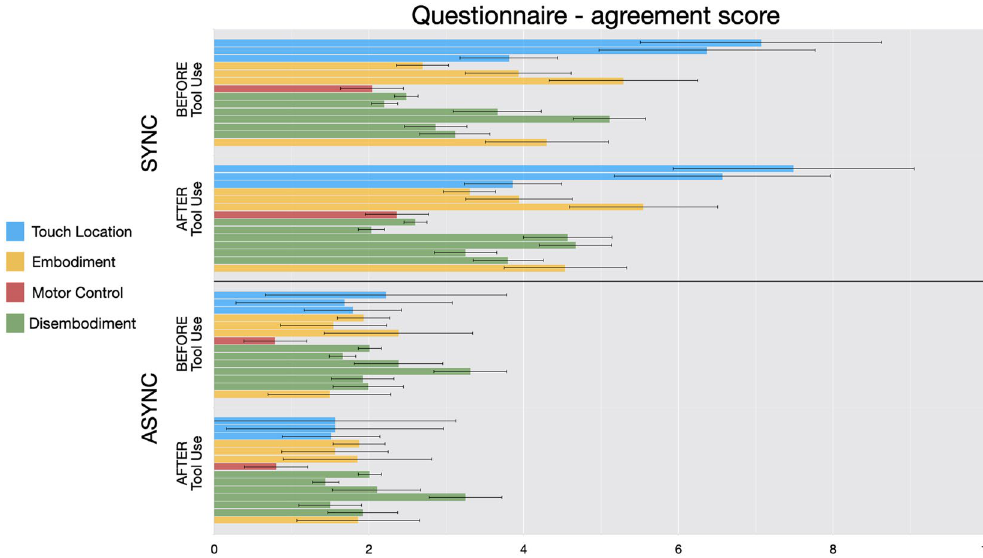
Figure 4. In Experiment 2, participants (N = 40) showed higher agreement for statement regarding changes in perceived touch location (Q1, Q2 and Q3 – light blue bars) and tool embodiment (Q5, Q6 and Q14 – yellow bars) after synchronous stimulation only. Error bars indicate 95% C. I.